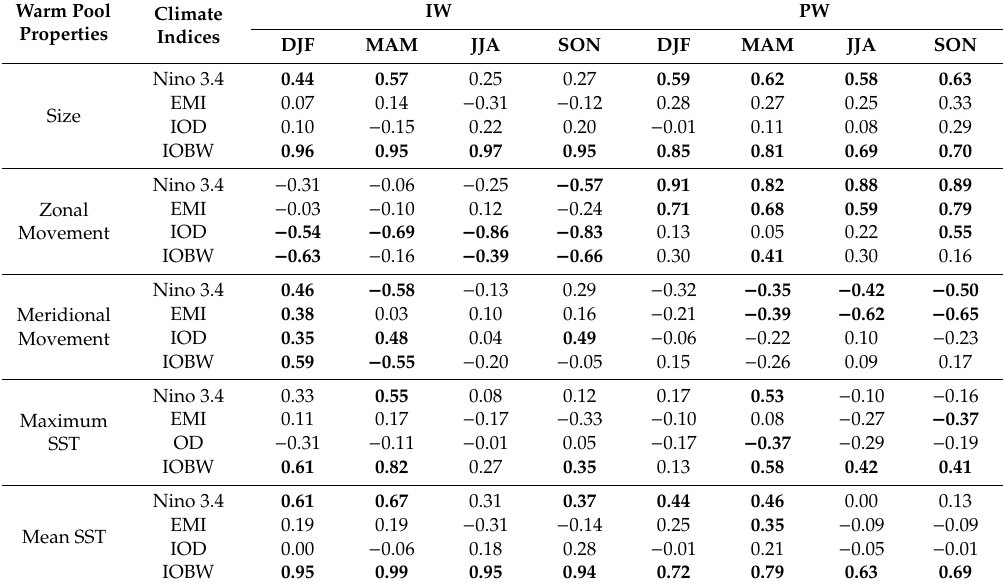
Table 1. The correlation coe ffi cients between the climate indices and seasonal warm pool properties of the IW and